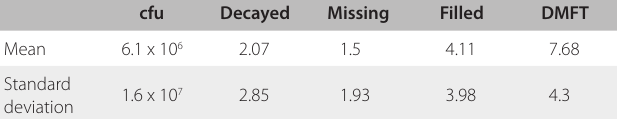
Table 2. Mean number of S. mutans colony-forming units (cfu), mean number of decayed, missing and filled teeth and mean DMFT index for the